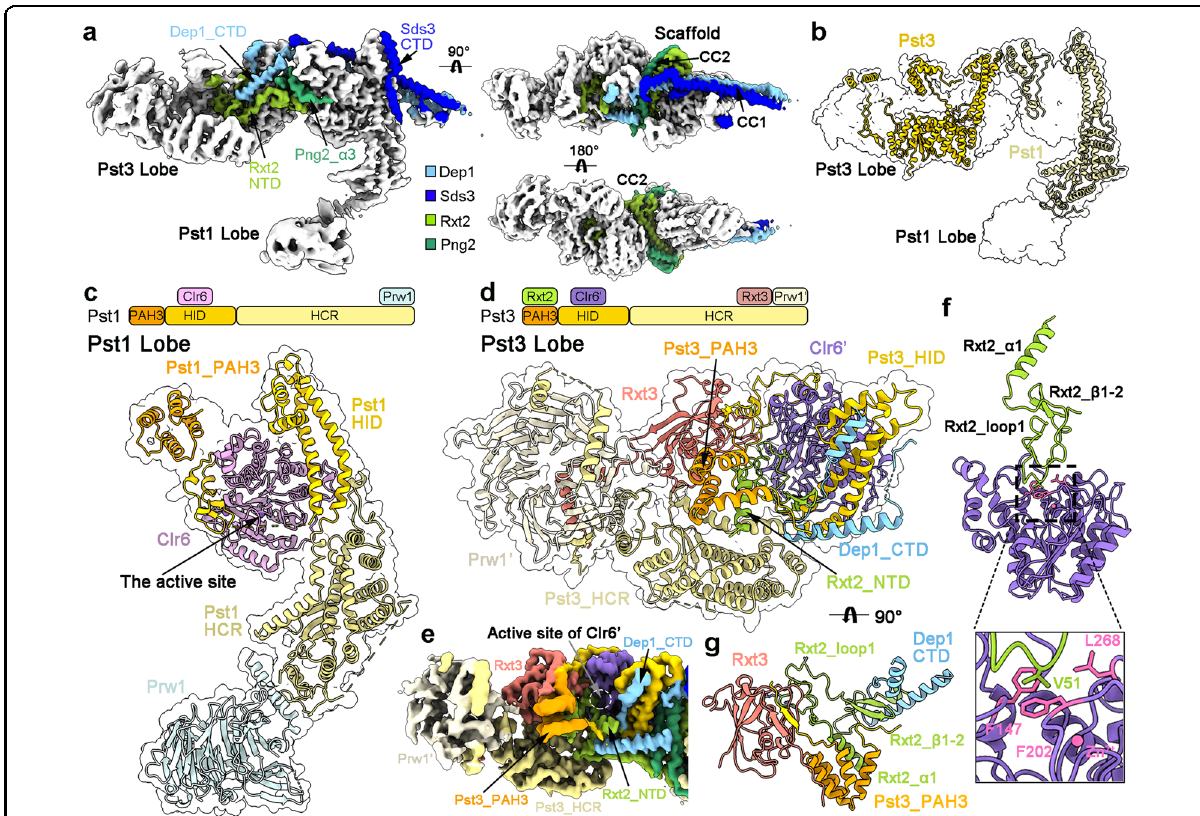
Fig. 2 Organization of the SIN3L complex. a The scaffold of the SIN3L complex. The scaffold proteins (including Sds3, Dep1, Rxt2, and Png2) are shown in colors with the Pst1/3 Lobe shown in gray. b Structures of Pst1 and Pst3 in the two lobes. c Structural features of the Pst1 Lobe. A cartoon model of the Pst1 Lobe in an extended conformation is shown in the upper panel. The Pst1_HID stabilizes the Clr6, and the Pst1_HCR interacts with Prw1. The active site of Clr6 is exposed to the exterior space. d Structural features of the Pst3 Lobe. A cartoon model of the Pst3 Lobe in a compact state is shown in the upper panel. The Pst3_HID stabilizes the Clr6 ’ , and the Pst3_HCR interacts with Prw1 ’ . The Pst3_PAH3 binds to the Rxt2_ α 1. The active site of Clr6 ’ is buried inside and blocked by the Rxt2_NTD. e The EM map of the Pst3 Lobe with protein components color-coded. f The close- up views of the interactions between Clr6 ’ and Rxt2_NTD. g The Rxt2_NTD is further stabilized in the Pst3